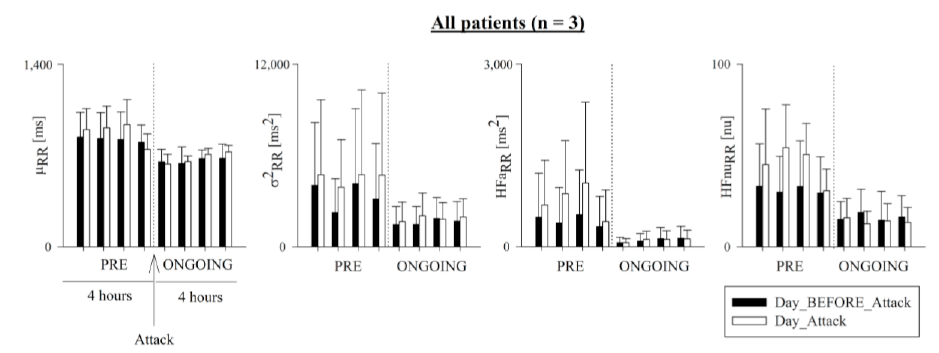
Figure 3. Temporal evolution of time- and frequency-domain HRV markers in all patients. Bar graphs show RR mean ( µ RR ), RR variance ( σ 2 RR ), and absolute (HFa RR ) and normalized (HFnu RR ) power in the HF band in all patients. Indices were calculated hour-by-hour in the 4 h preceding (PRE) and the first 4 h following the onset of the HAE attack (ONGOING) on the day of the attack (Day_Attack, white bars), and compared to data during the same circadian phase on the day before (Day_BEFORE_Attack, black bars). Results shown as mean ± standard deviation.